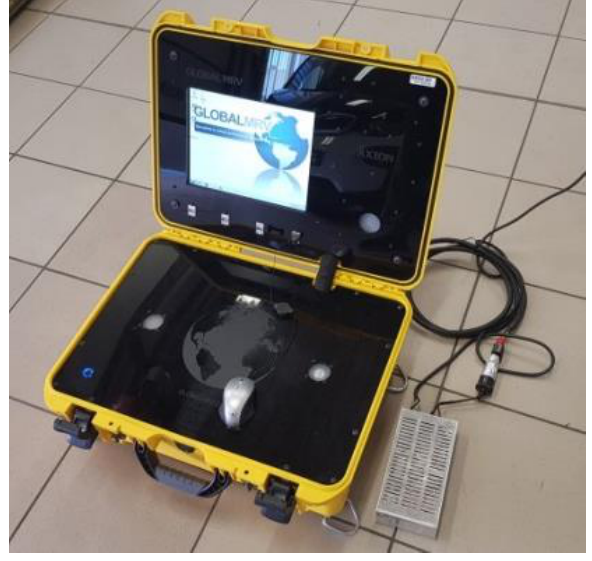
Fig. 4. The view of AxionR/S+ Table 3. AxionR/S+ device technical data [13]